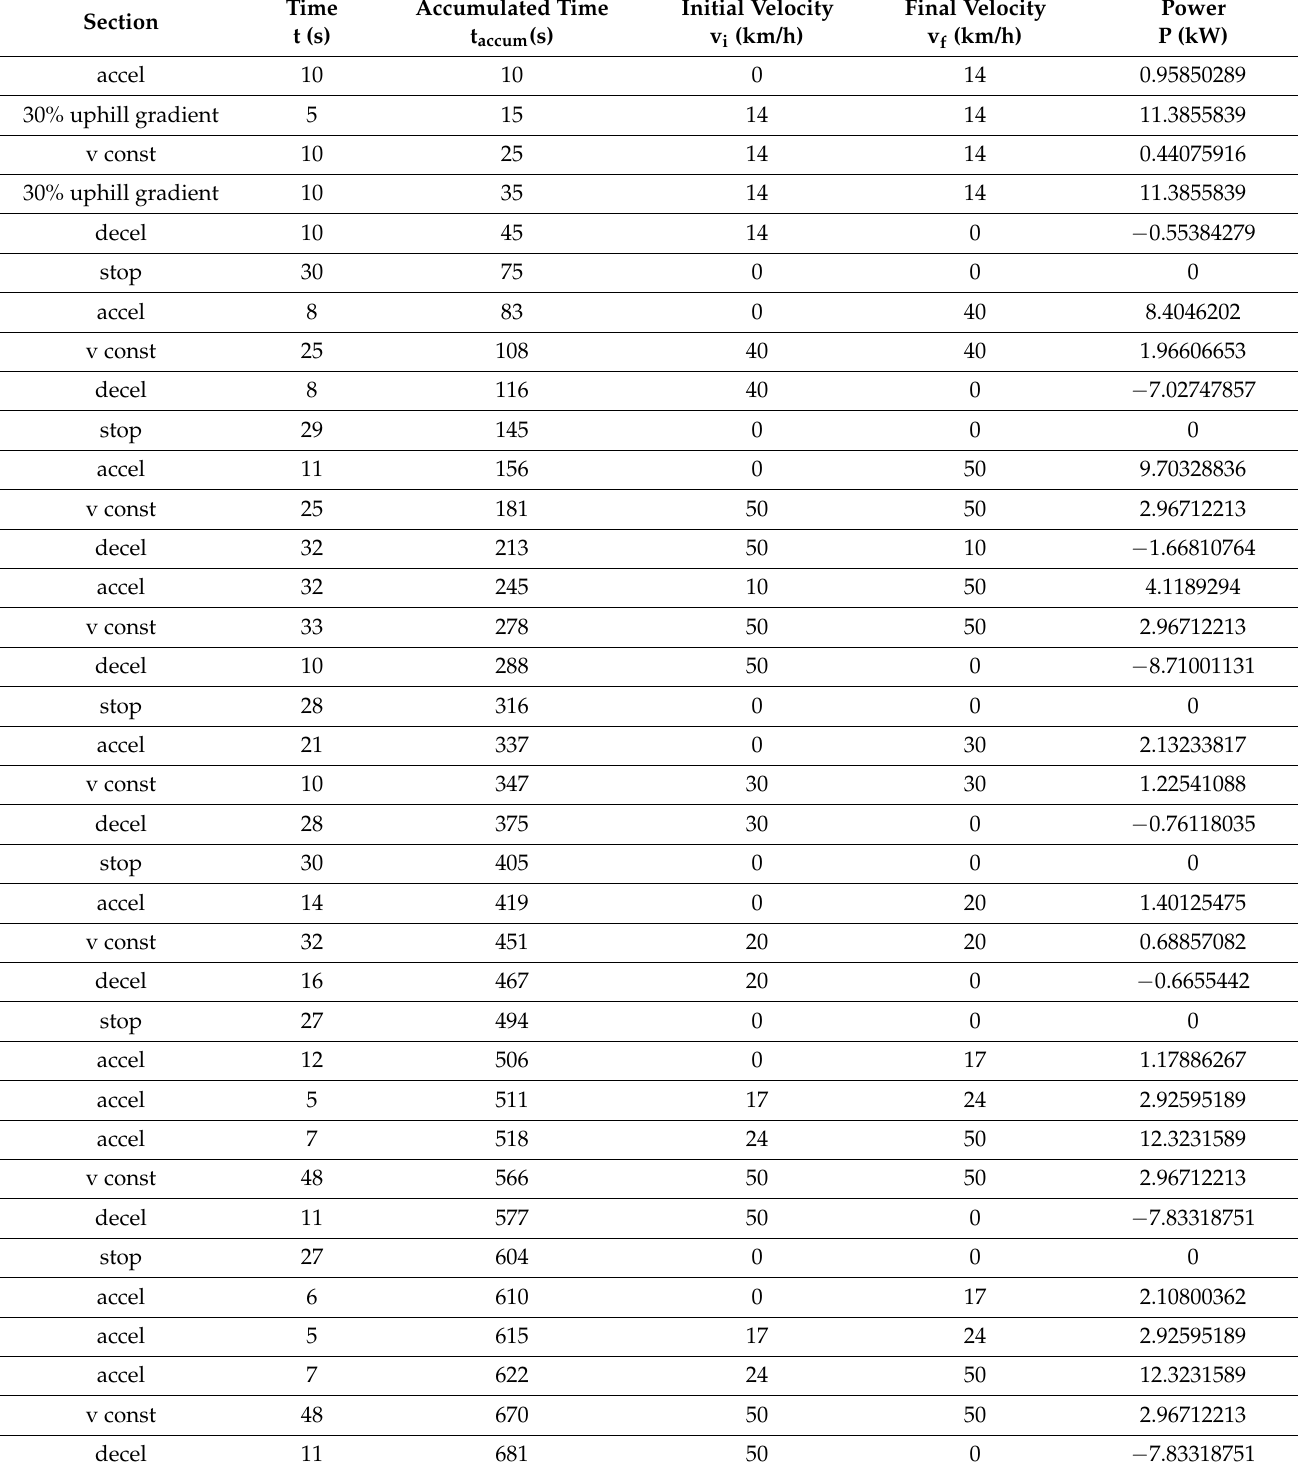
Table 2. Driving characteristics for scenario